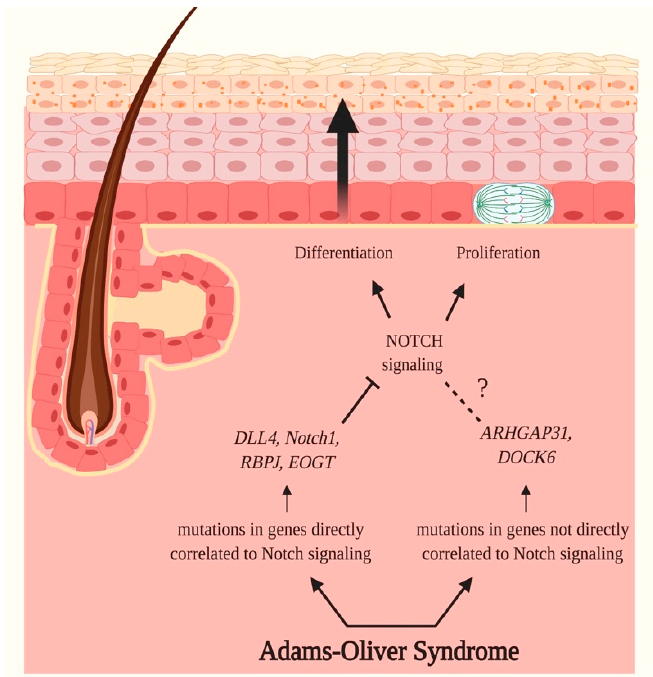
Figure 7. Adams–Oliver Syndrome and Notch signaling. Adams–Oliver Syndrome (AOS) is a rare inherited disorder characterized by aplasia cutis congenita of the scalp, terminal transverse limb defects, vascular anomalies, pulmonary and portal hypertension, and retinal hypervascularization. 71% of identified mutations in AOS cases have been identified in genes directly correlated to Notch signaling, therefore suggesting the crucial role of this pathway in the onset of AOS. Mutations have been registered in Notch1 , DLL4 , RBP-J κ and EOGT genes, encoding, respectively, for Notch1, Delta-like 4 ligand (DLL4), Recombination Signal Binding Protein for Immunoglobulin Kappa J Region (RBP-J κ ) and EGF domain-specific O-linked N-acetylglucosamine transferase (EOGT). The identified genetic variants impact the maturation of receptors, receptor-ligand binding and interaction, and ultimately the transcription of target genes. As a consequence, these mutations cause a disruption of Notch signaling, therefore negatively impacting proliferation and di ff erentiation of epidermal cells. The remaining 29% of AOS cases carry causative variants in ARHGAP31 , encoding for the Rho GTPase-activating protein 31 (ARHGAP31), and DOCK6 , encoding for guanine nucleotide exchange factor (GEF), which are not directly associated with Notch signaling. The products of these genes are regulatory proteins implied in the formation of actin cytoskeleton and are consequently involved in cell morphology, cell migration, survival and division; therefore, variants in these genes are thought to negatively regulate these fundamental processes. Pointed arrows ( → ) define the induction of the indicated process or associated function, while the truncated arrow (T) designates the inhibition of the described process. The dotted line (—) indicates a proposed association that still needs to be clarified.